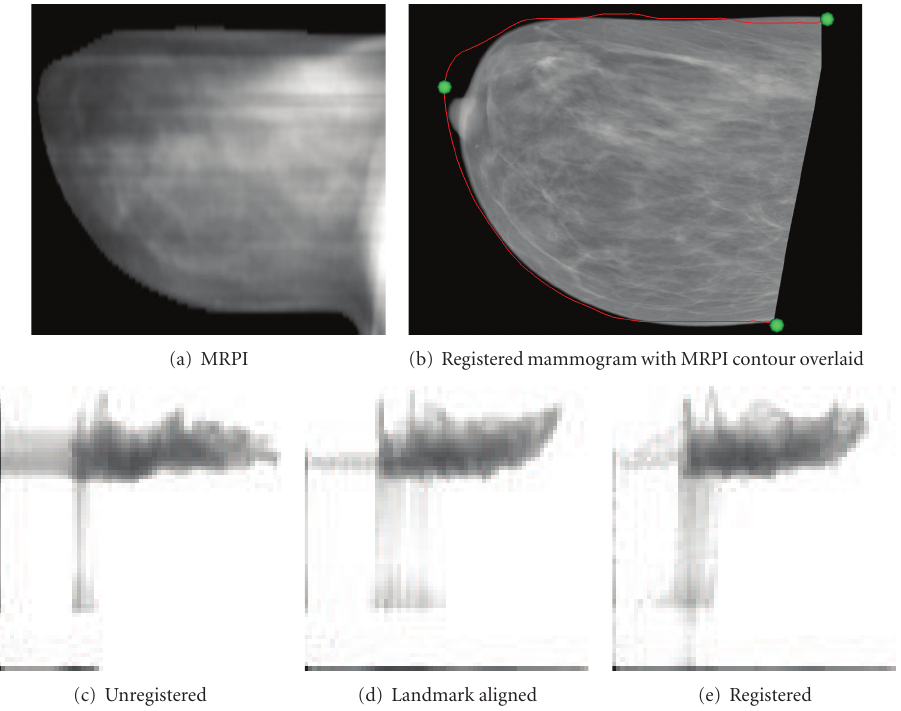
Figure 14: An example of deformation resulting from contact with the MR system